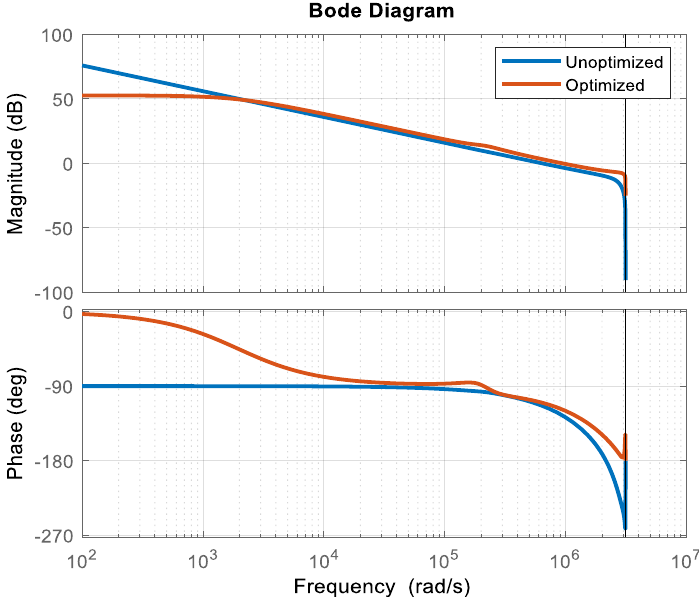
Table 3. Comparative analysis of controllers’ performance characteristics.